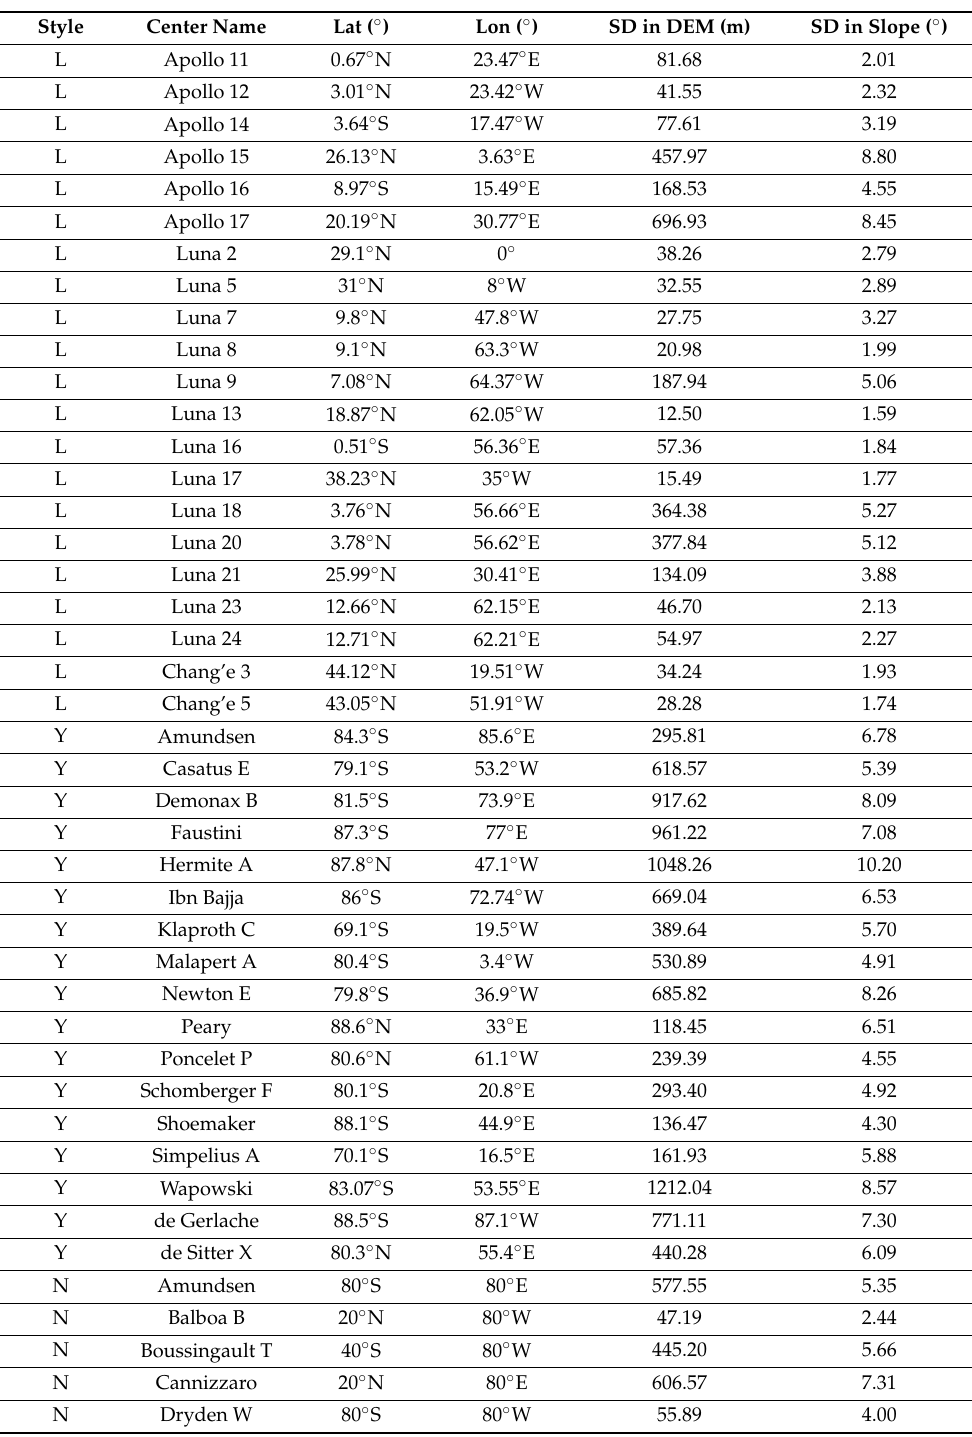
Table A5. The table contains basic information about analyzing areas centered on given sites. Here in the ‘style’ column, ‘L’ indicates the past landers’ center position, ‘Y’ indicates the area centered in a crater, ‘N’ indicates the area centered on a given (Lat, Lon) position, where closest to the assuming closest crater is labeled ‘Center name’. The SD in DEM and slope are both described according to area